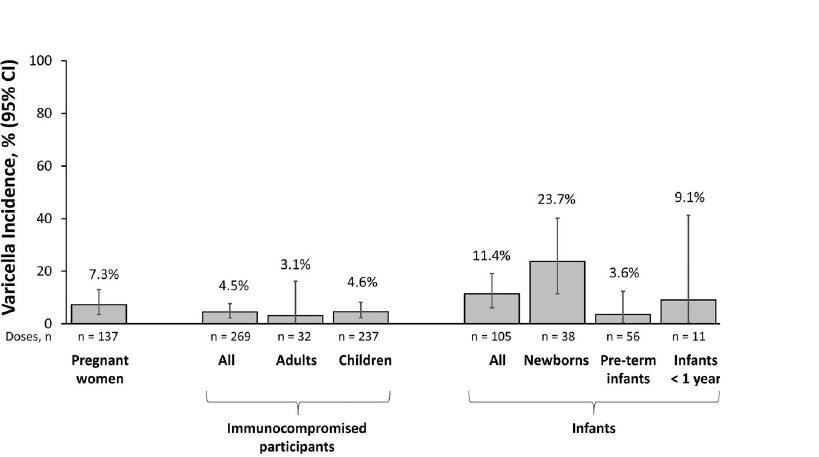
Fig 2. Incidence of varicella by high-risk participant group. CI confidence